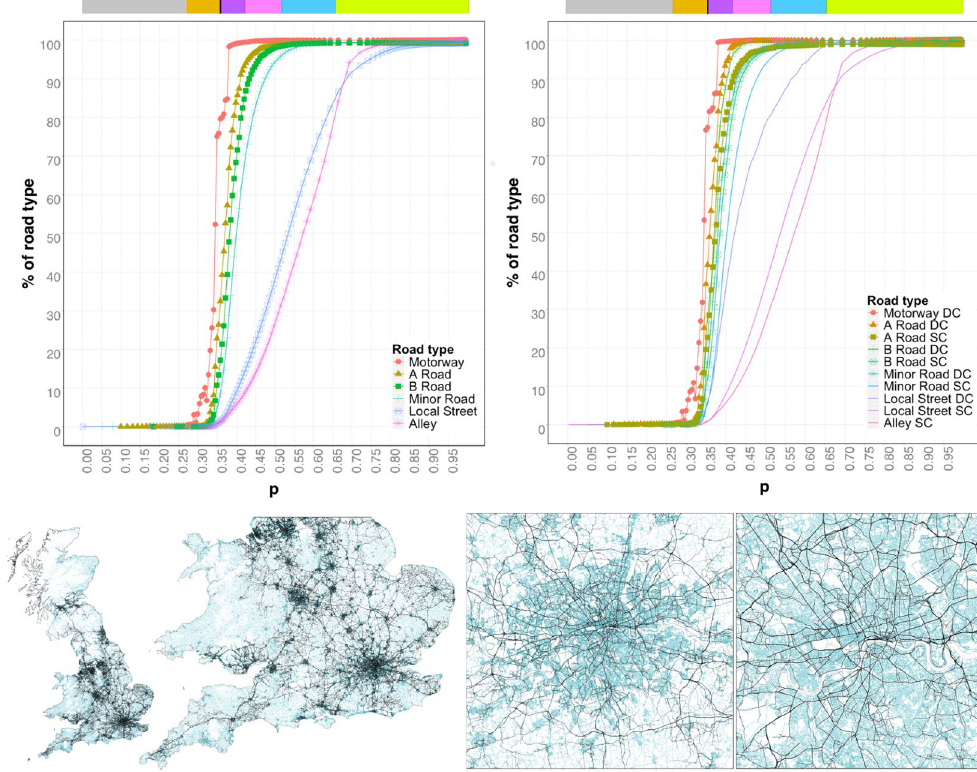
Figure 2. Upper panel, percentages of roads by road type that belong to the giant cluster at the different percolation thresholds (in right panel, DC: dual carriageway, and SC: single carriageway), the colors on top of the plots represent the regimes obtained with the entropy. Lower panel, giant cluster just after the phase transition (in black) overlaid to the full set of roads of the road network (in light blue).